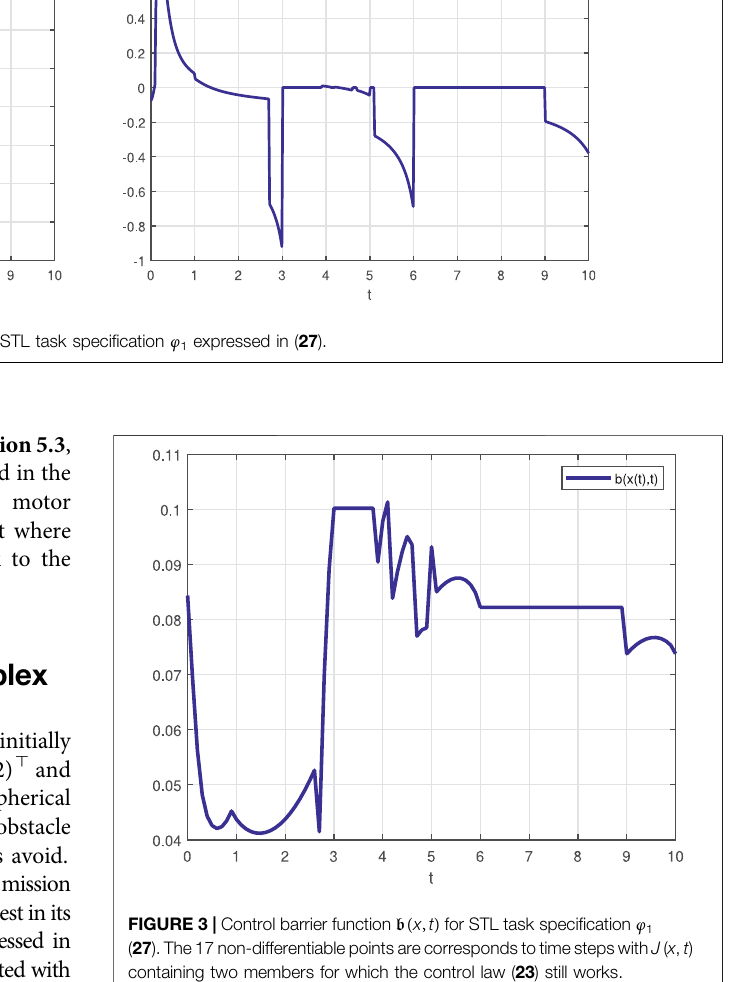
Figure 1 gives successive snapshots of the robot ’ s path through the workspace, as it is steered by the control law computed based on the process outlined in Section 4.2 . The time instances associated with the snapshots showcased correspond to appearing in the STL speci fi cation φ 1 in ( 27 ). First of all, as a result of maximum operator, visiting ( μ 1 ∨ μ 2 ) at t = 3 is preferred location of the robot. For the same reason, between μ 1 and μ 2 , the former is selected to be visited at time t = 3. It should continue to remain inside the union of μ 1 and μ 2 (to ensure ( μ 1 ∨ μ 2 ) remains true) from t = 3 until t = 7, which is veri fi ed in the sequence of